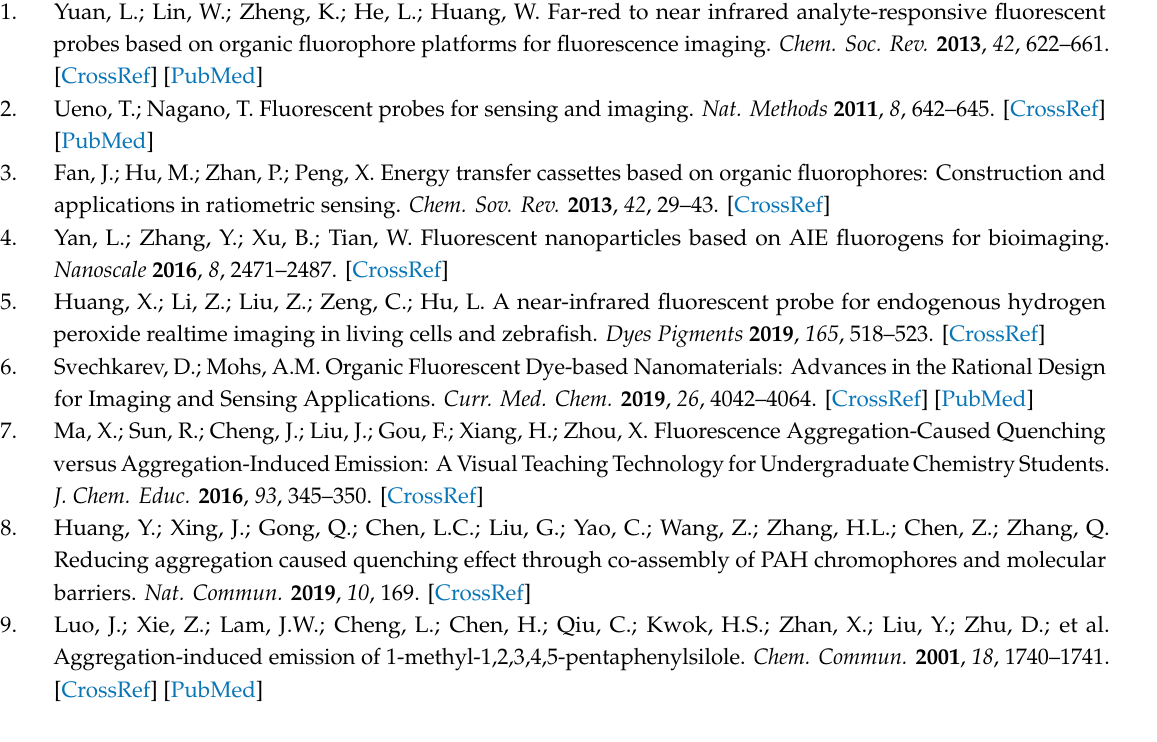
Supplementary Materials: The following are available online. Figure S1: 1H, 13C NMR spectra and ESI-MS analysis for compound 1. Figure S2: 1H, 13C NMR spectra and ESI-MS analysis for compound 2. Figure S3: 1H, 13C NMR spectra and ESI-MS analysis for compound 3. Figure S4: 1H, 13C NMR spectra and ESI-MS analysis for compound 4